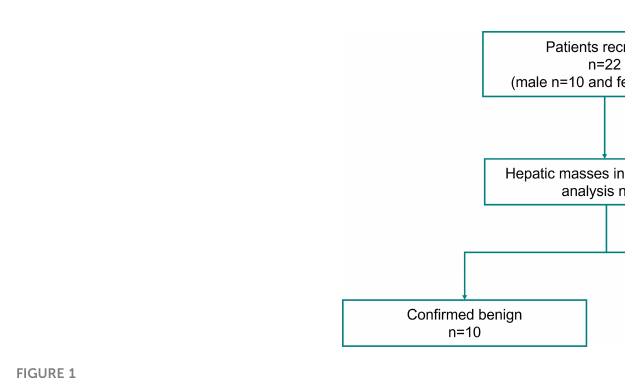
FIGURE 1 Participants fl